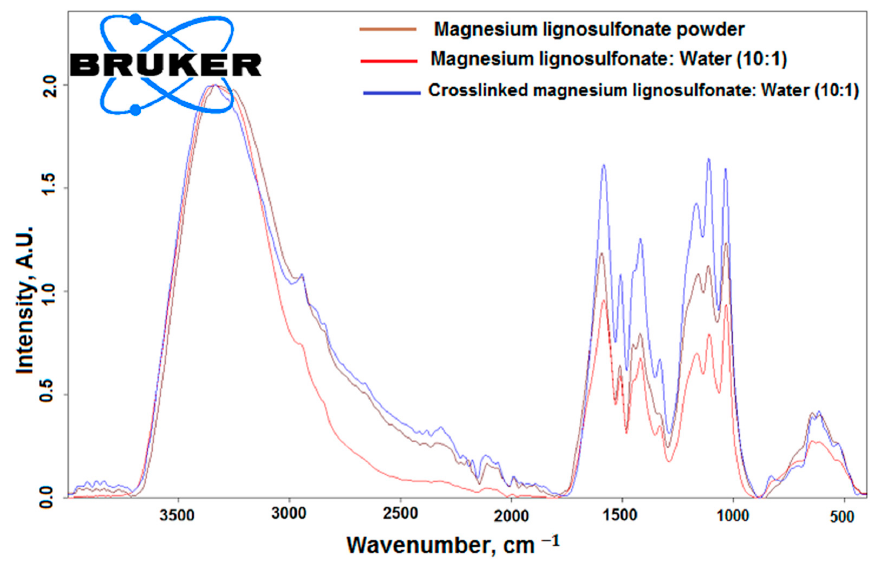
Figure 1. FTIR analysis for (LIGNEX MG F) powder and mixed LIGNEX MG F—water (air-dried and crosslinked).